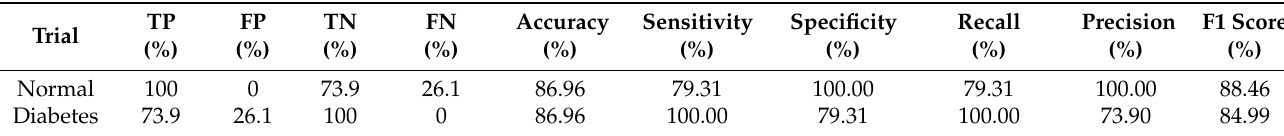
Table 3. Classification performance of weighted KNN classifier.